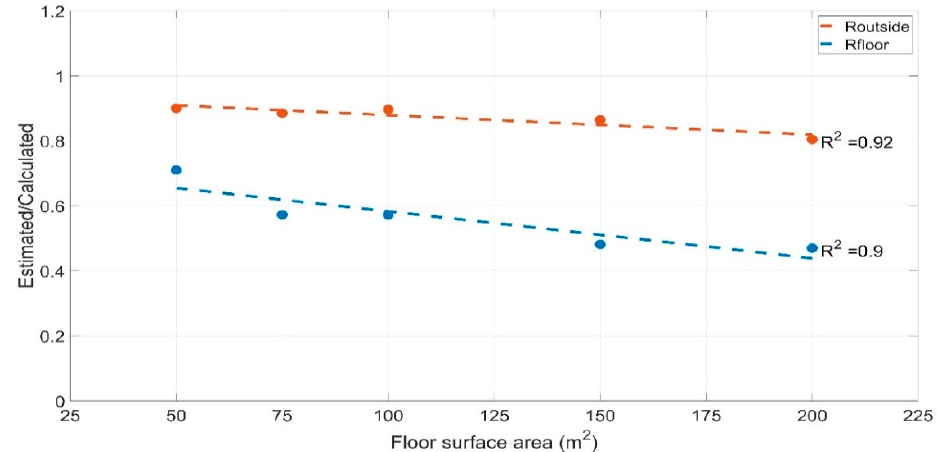
Figure 9. Estimated/calculated ratio of resistances for different floor surface areas in x-2-15-0 heavy-structured buildings.